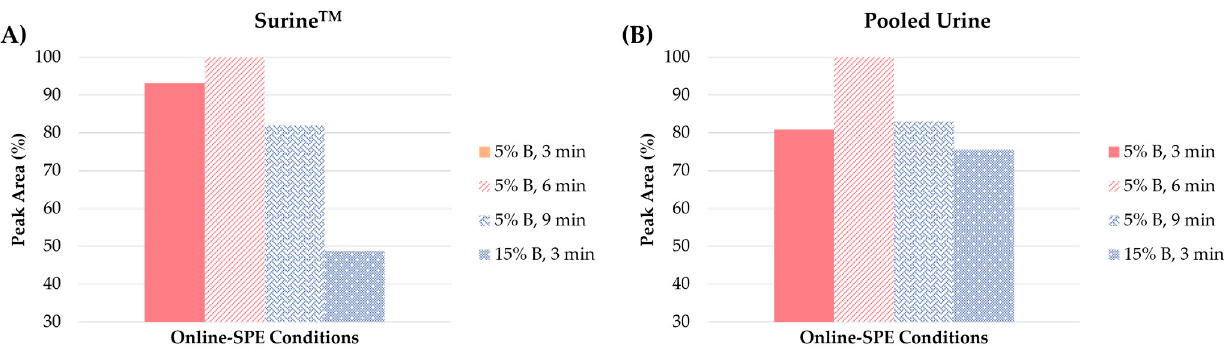
Figure 5. Influence of the different concentrations of solvent B (methanol) in the loading solution (5% or 15%) and the time of the loading and washing step (3, 6 or 9 min) on the peak area of clen- buterol in ( A ) Surine TM and ( B ) pooled urine.